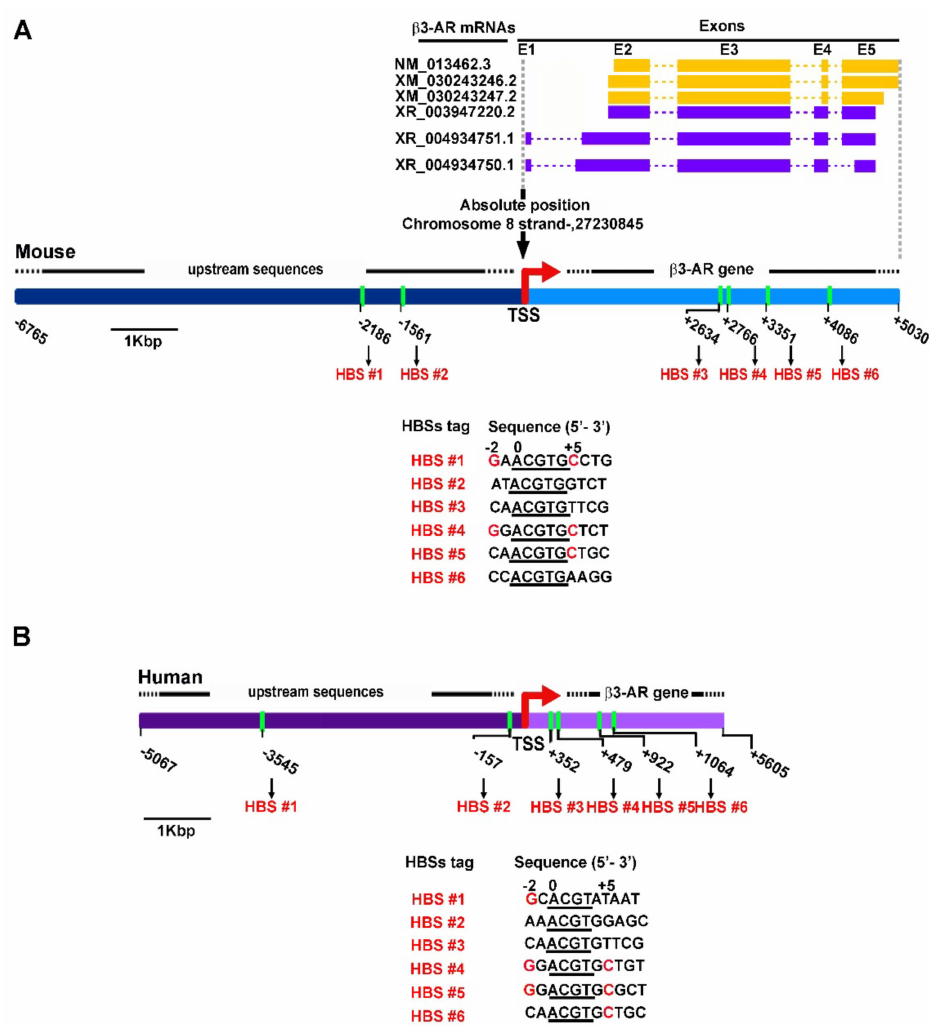
Figure 2. Schematic representation of mouse and human β 3-AR genes including their upstream sequences. ( A ) In the mouse gene, 5 exons (E1–E5; solid boxes) and 4 introns (dashed lines) are depicted. They potentially express up to 6 different alternative mRNAs of which 3 codify for the canonical β 3-AR protein (yellow mRNAs) while the other 3 for an alternative β 3-AR protein with a different C-terminal sequence (purple mRNAs). The putative transcription-start site (TSS) is indicated by the red arrow. The positions of the 6 potential HBSs relative to the TSS are in green. All of them contain the minimal HBS consensus sequence (underlined sequence 5 (cid:48) -ACGTG-3 (cid:48) ). ( B ) In the human gene, the positions of the 6 potential HBSs relative to the TSS are in green. All of them contain the minimal consensus sequence (underlined sequence 5 (cid:48) -ACGT-3 (cid:48) ). The putative TSS is indicated by the red arrow. The highly conserved nucleotides G − 2 and/or C +5 in the mouse and human HBSs sequence are highlighted in